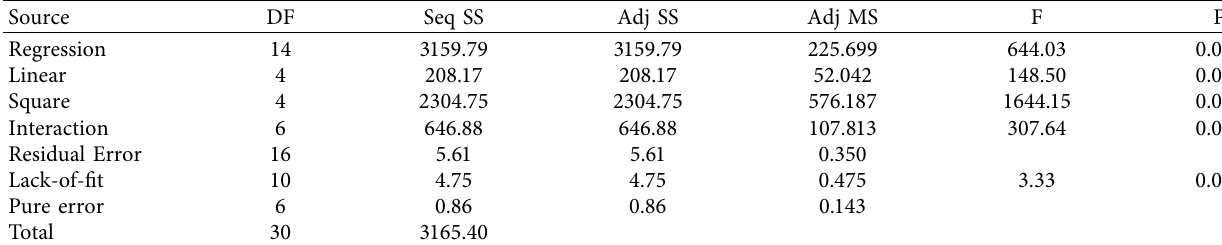
Table 4: Analysis of variance for MRR